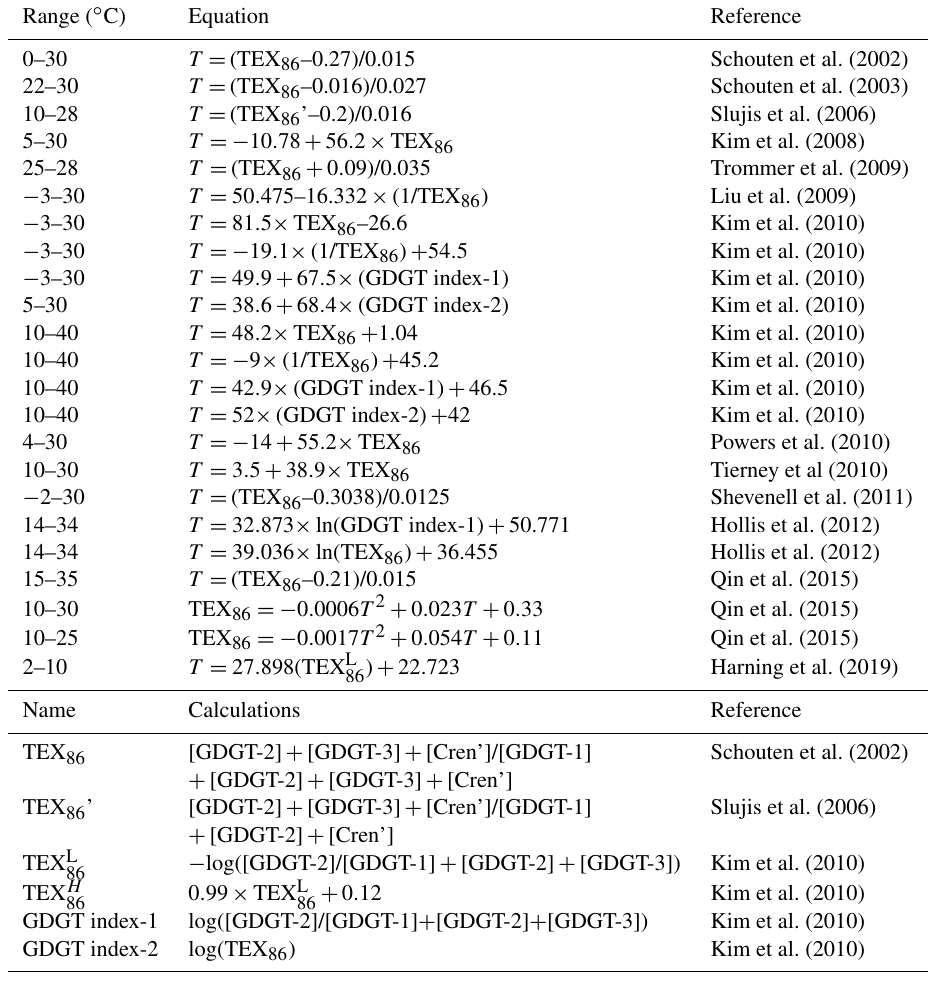
Table 1. Compilation of TEX 86 calculations and calibrations as of 2020. Modified from Tierney